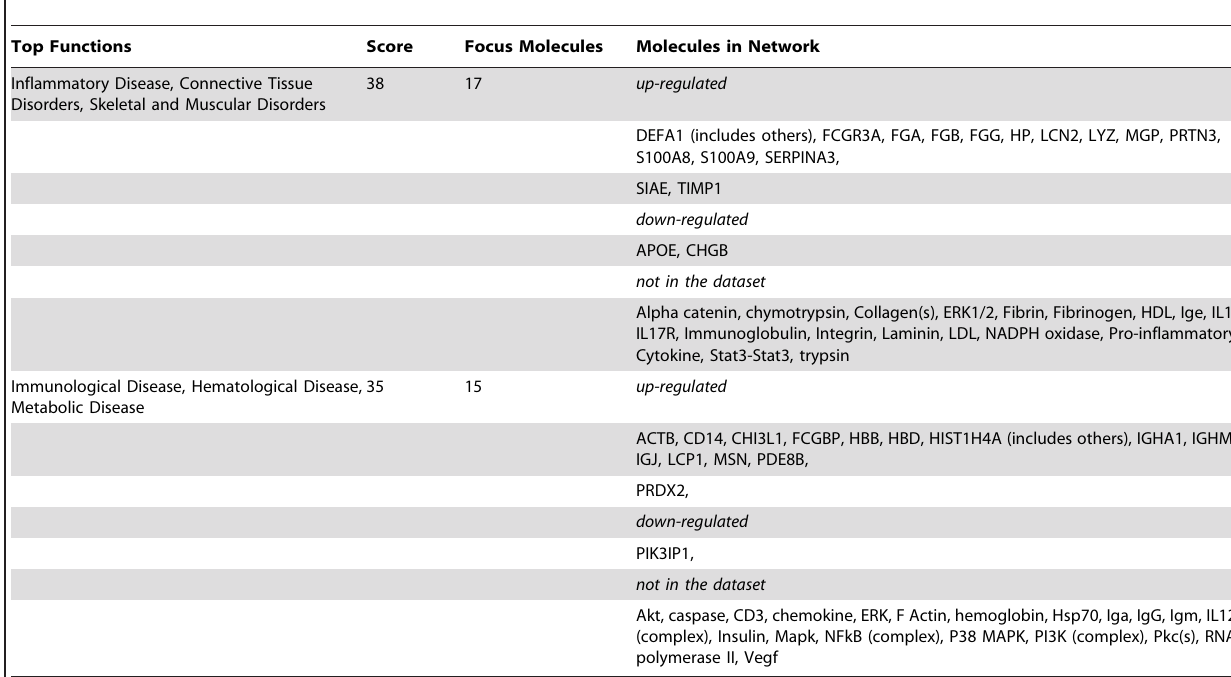
Table 4. IPA-generated networks of differentially expressed proteins identified by iTRAQ labeling between CSF samples from WNND ( i.e. , A2 group) and AH- and IIH-control groups ( i.e. , C2 and C3 groups).